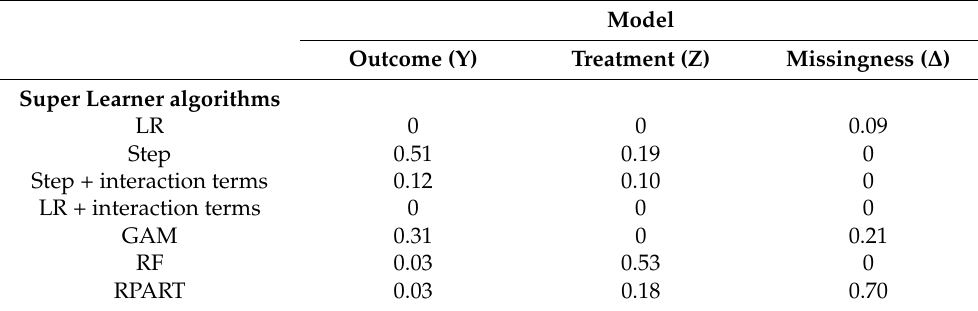
Table 2. Coefficients of the algorithms selected by the super learner algorithm in TMLE2 (IPW) for the DARWIN T2D